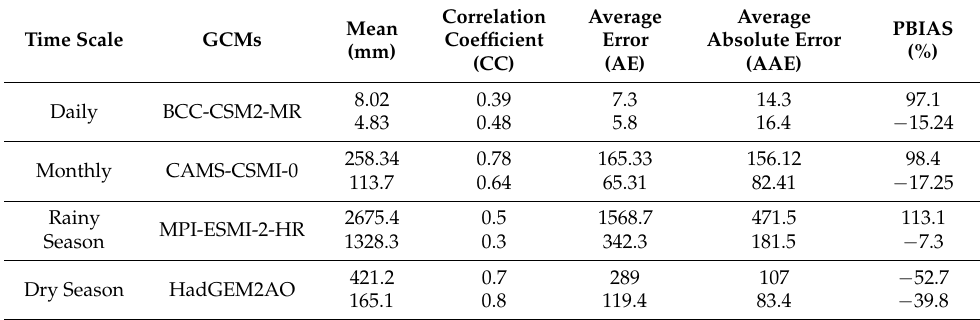
Table 6. GCMs and RCP rainfall data on the Kunhar River Basin from 2000 to